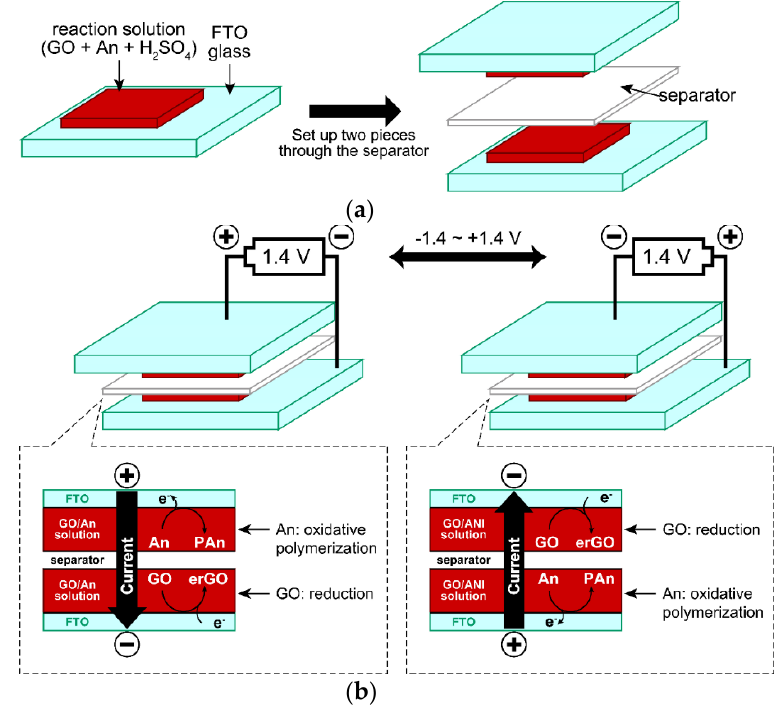
Figure 6. Illustration of a two-electrode cell for electrochemical conversion of GO/An to the erGO/PAn composite: ( a ) Set-up of the cell, ( b ) Redox reaction occurring at both electrodes.